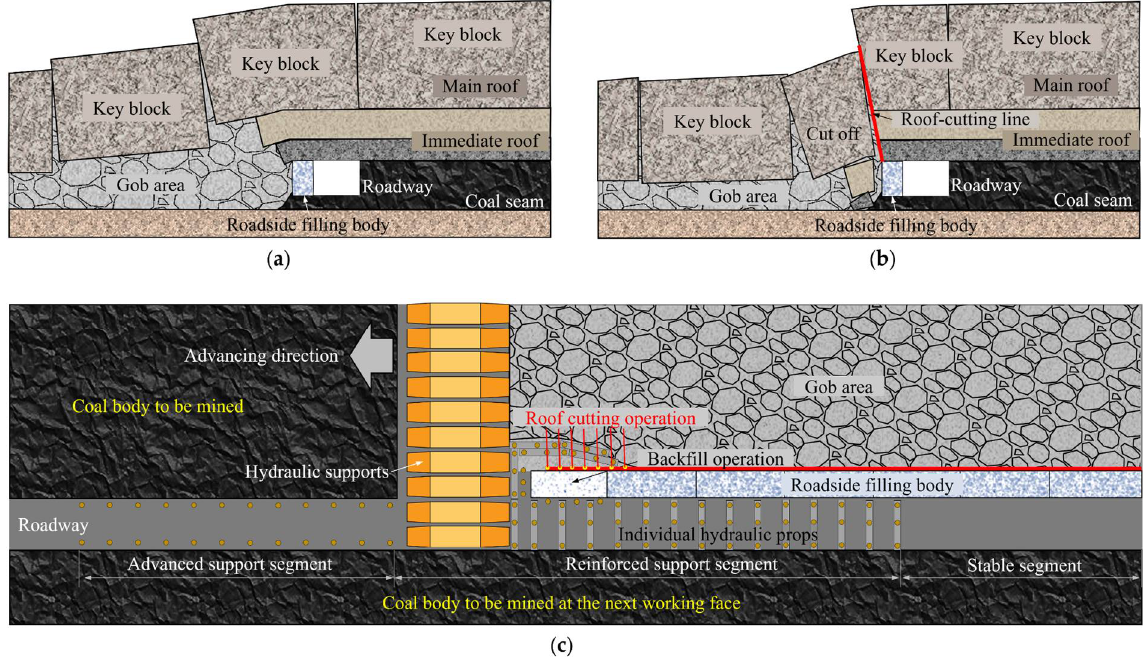
Figure 10. Delayed pre-splitting and cutting roof for gob-side entry retaining. ( a ) Gob-side entry retaining with backfill ( b ) Cutting roof on goaf side ( c ) Working methods of roof-cutting and gob-side entry retaining with backfill.